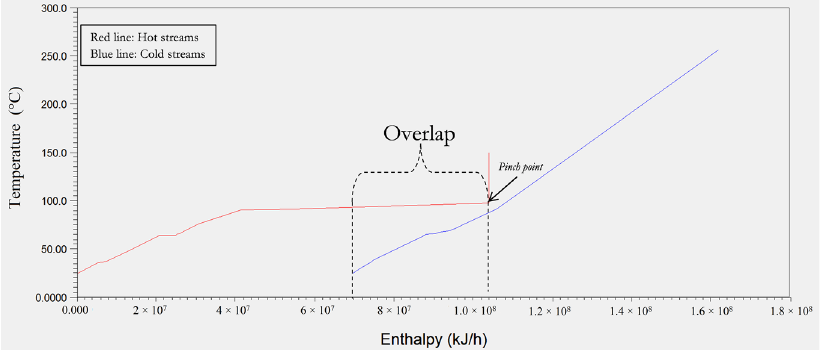
Figure 3. Composite curves for minimum driving temperature of 10 °C for the biorefinery process as generated by ASPEN energy analyser ® .